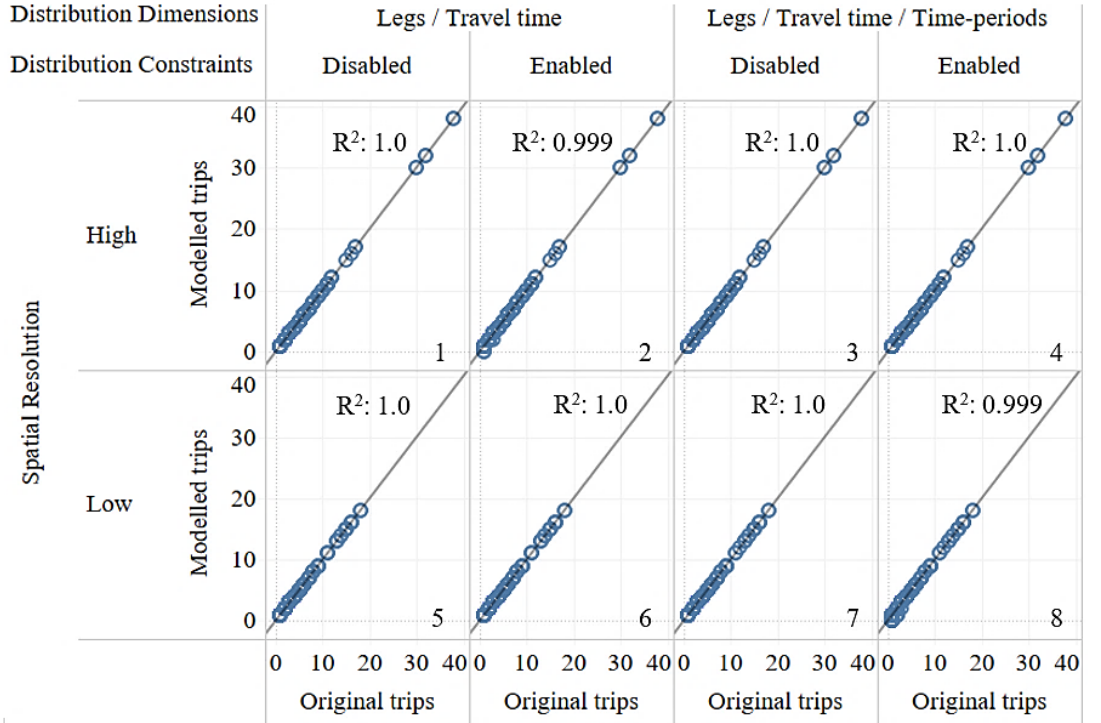
Figure 5. Pairwise comparison of the original and the modelled OD